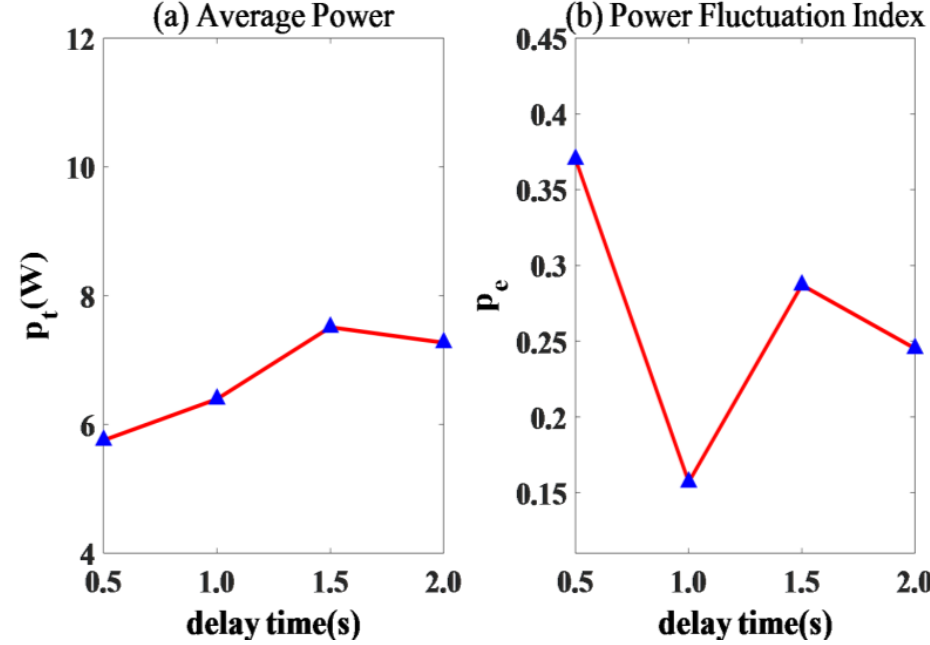
Figure 11. The average output power and power fluctuation index under different delay times (trigger pressure is 3.5 MPa).